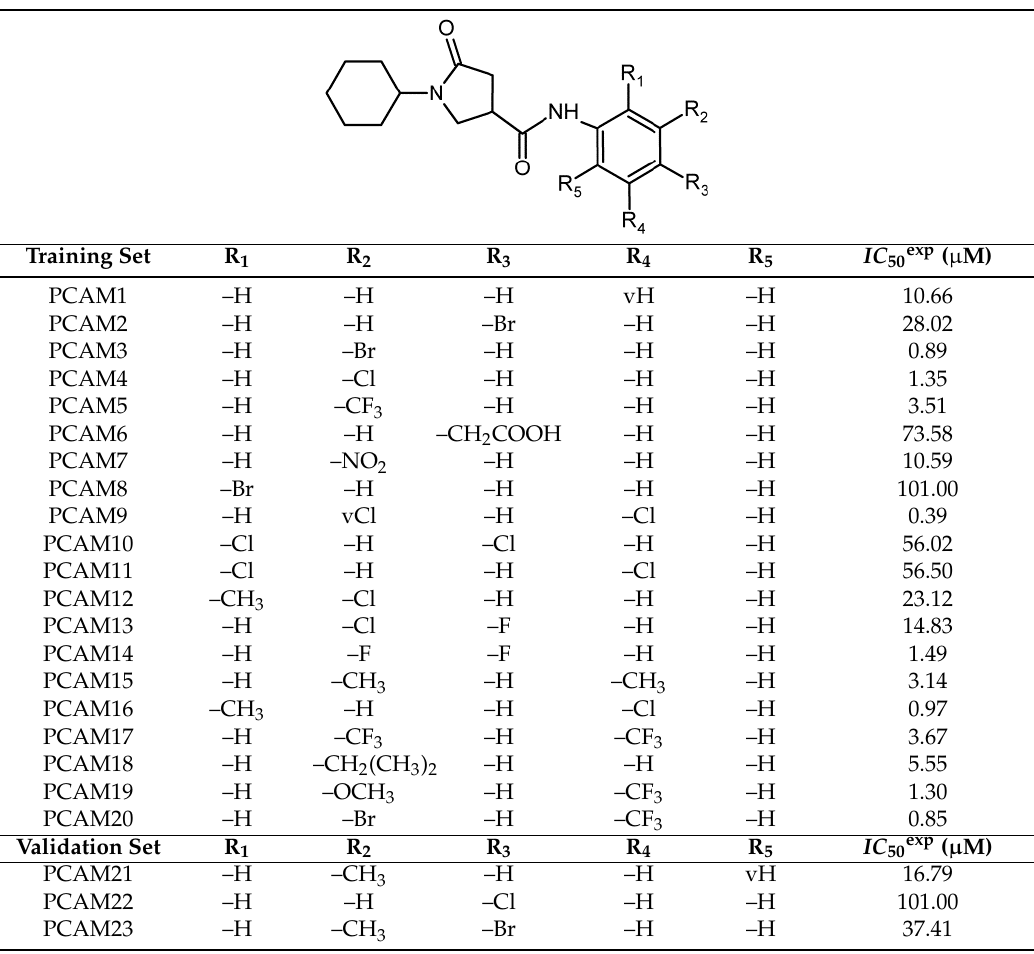
Table 1. Training set and validation set of pyrrolidine carboxamide (PCAMx) inhibitors of enoyl-acyl carrier protein reductase (InhA) [12] used in the preparation of quantitative structure-activity relationships (QSAR) model of inhibitor binding.